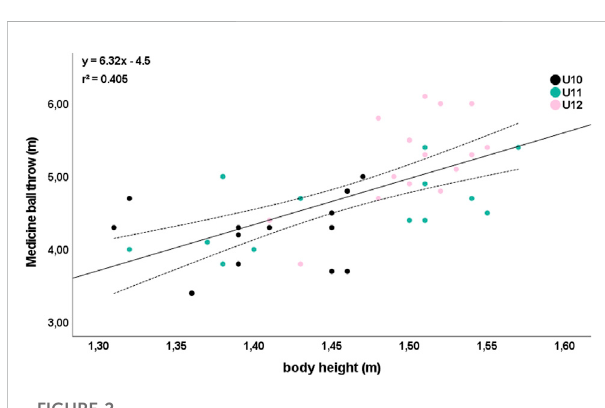
Relationship between body height and medicine ball throw. Please note that one dot can represent several